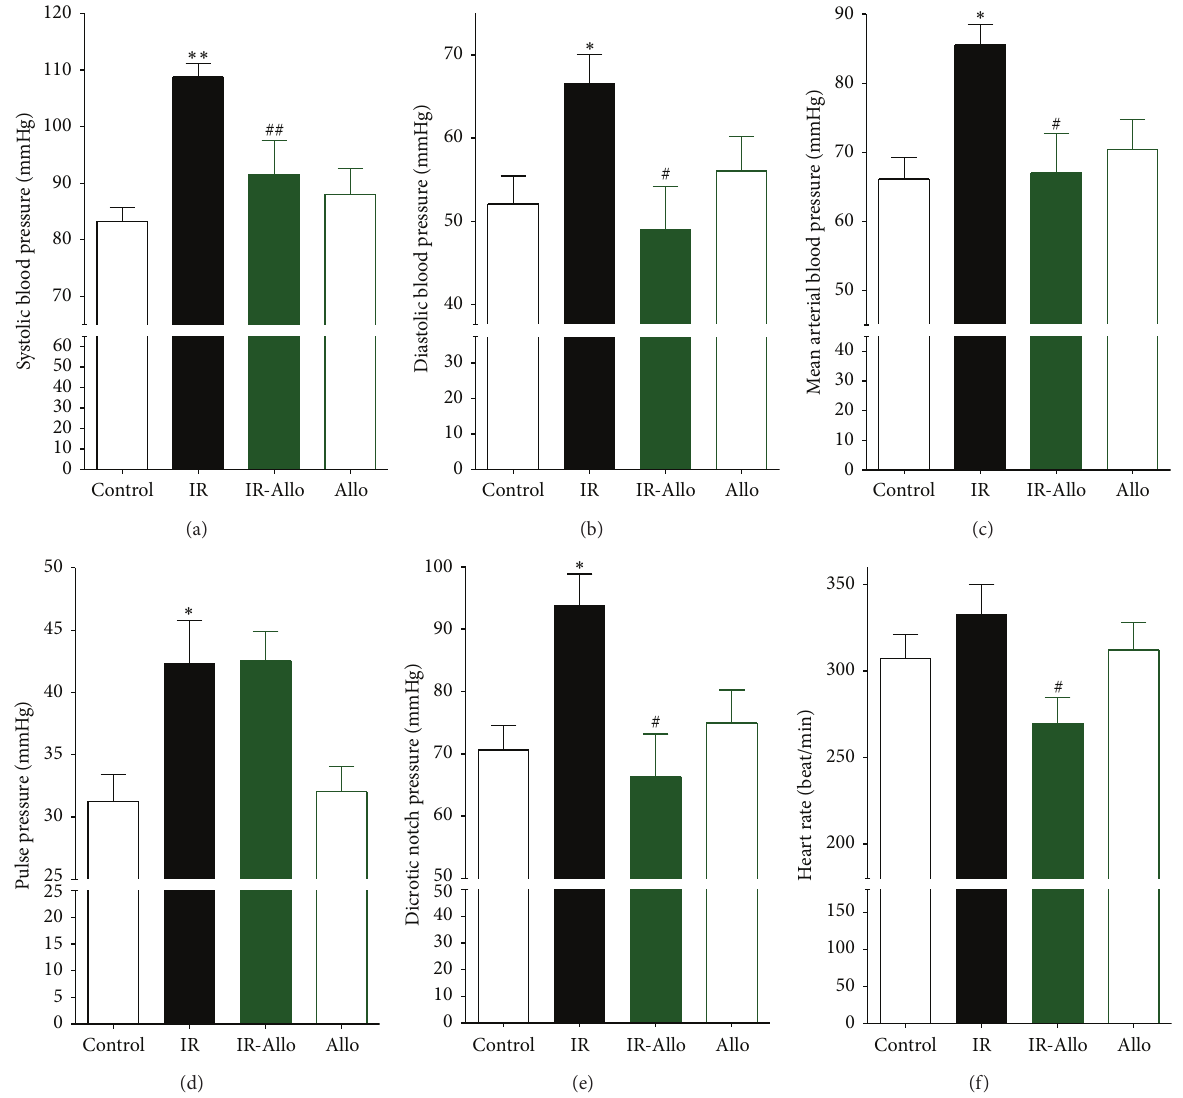
Figure3:Theeffectofallopurinol(Allo)treatmentoninsulinresistance(IR)inducedBPchangesmeasuredinmmHgandheartratemeasured as beats/minute compared to control group (C). (a) Systolic BP, (b) diastolic BP, (c) mean arterial BP, (d) pulse pressure, (e) dicrotic notch pressure, and (f) heart rate. Values are expressed as the mean ± SEM; 𝑁 = 6 – 8 animals; ∗ 𝑃 < 0.05 and ∗∗ 𝑃 < 0.01 compared with the corresponding control (C) group values; # 𝑃 < 0.05 and ## 𝑃 < 0.01 compared with the corresponding IR group values, by One-Way ANOVA and Newman-Keuls post hoc